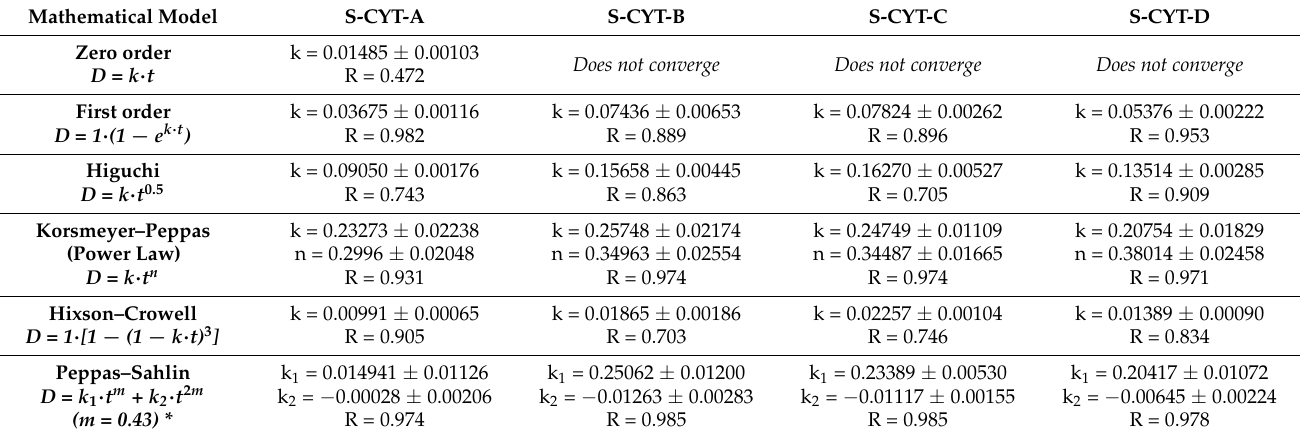
Table 4. Mathematical models fitted to the experimental release curves: calculated fitting parameters and square of coefficient of determination (R2). Data were fitted until the 90% of CYT was released (75, 40, 50 and 55 min for S-CYT-A, S-CYT-B, S-CYT-C and S-CYT-D respectively).